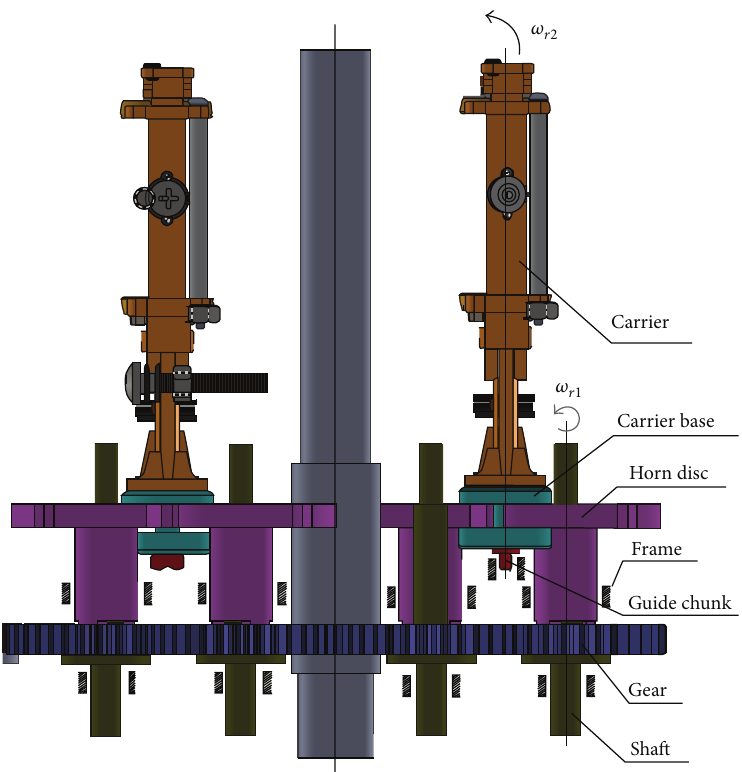
Figure 1: Motion system of the braiding